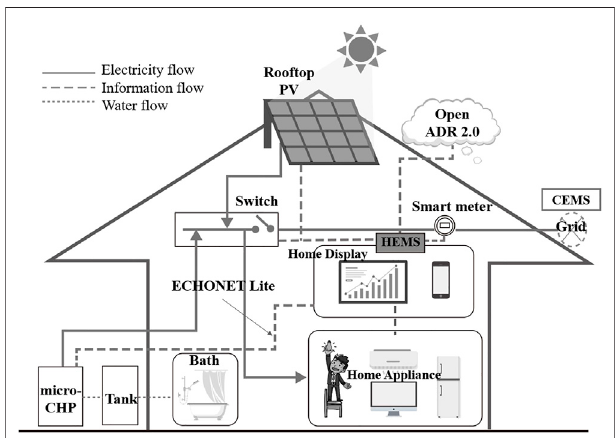
FIGURE 3 | Overview of a ZEH equipped with